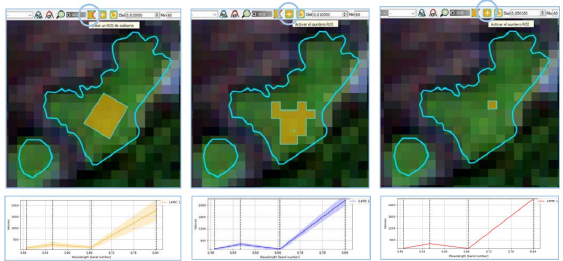
Figure 8 Spectral detector obtained using SCP with different selection parameters. Depending on the number of pixels in the considered region, we obtain an estimator of the spectral signature of the